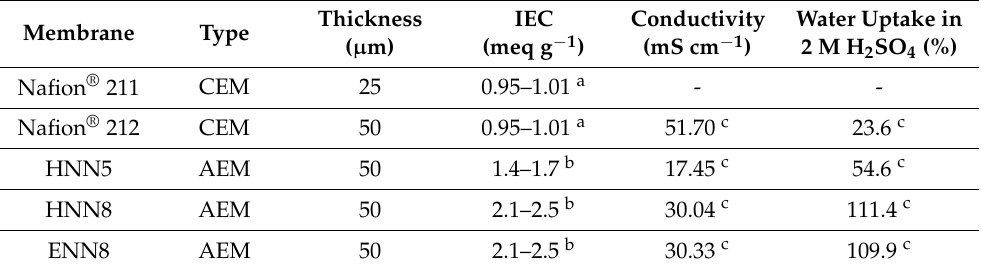
Table 1. Basic properties of tested membranes. Data supplied from a FuelCellStore, b Ionomr, c